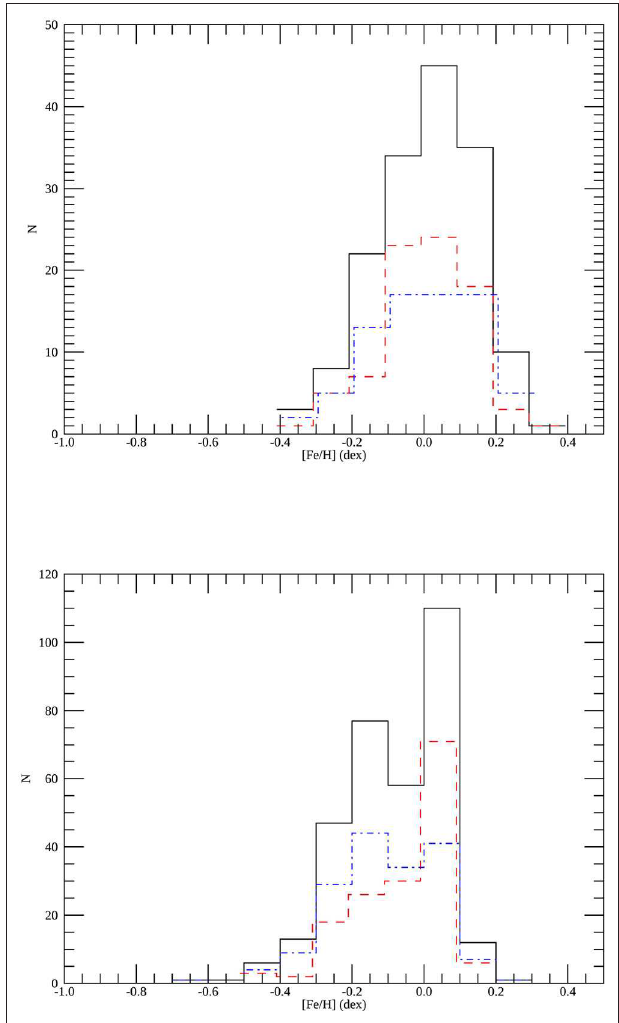
FIGURE 14 | Histogram of metallicity for the non-oscillating stars using APOGEE DR14 for 158 stars (top) and LAMOST DR2 for 326 stars (bottom panel) . The full sample in each panel is represented with the black solid line. Blue dot-dash line corresponds to the least active stars ( S ph < S ph, ⊙ ,max ) while red dash line corresponds to the most active stars ( S ph > S ph, ⊙ ,max